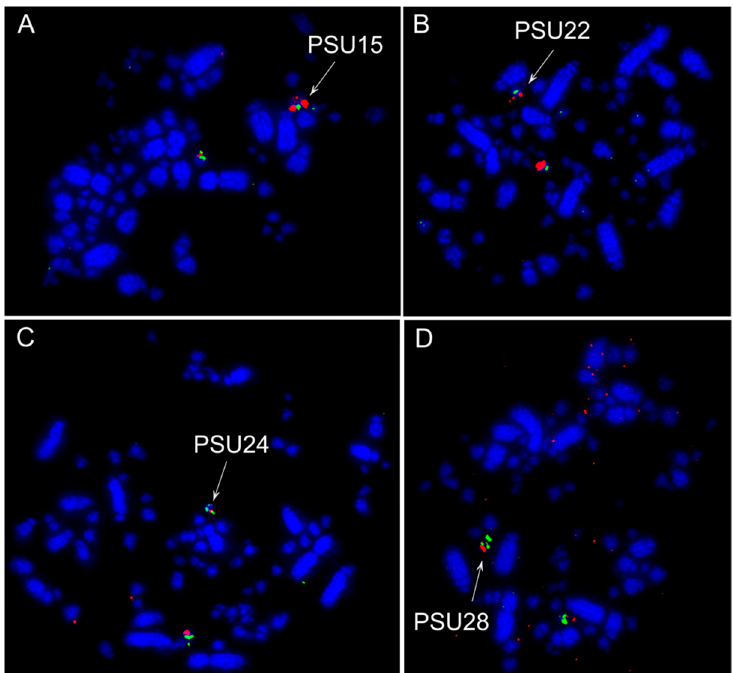
Figure 3. Representative cross-species hybridization results using G . gallus (CH261) and T . guttata (TGMCBA) BAC probes on Pitangus sulphuratus metaphases. ( A ) G . gallus microchromosome 13 CH261-115I12 (green) and TGMCBA-321B13 (red); ( B ) G . gallus microchromosome 20 TGMCBA- 250E3 (green) and TGMCBA-341F20 (red); ( C ) G . gallus microchromosome 22 CH261-40J9 (green) and CH261-18G17 (red); ( D ) G . gallus microchromosome 26 CH261-186M13 (green) and CH261- 170L23